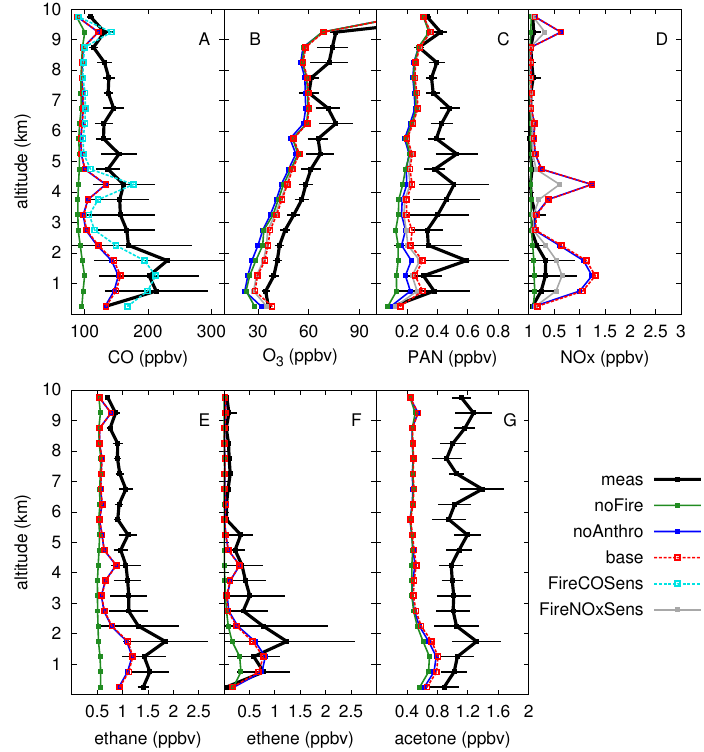
Fig. 3. Vertical profiles (averaged along flight tracks) for CO, ozone, PAN, NO x , ethane, ethene, and acetone for the ARCTAS-B flights over Canada compared to WRF-Chem results – measurements are in black, the model base run is in red, the noFire run is in green, and the noAnthro run is in blue. Two fire emissions sensitivity runs are shown, the FireCOSens run is shown in teal (CO plot only) and the FireNOxSens run is shown in the ozone, PAN, and NO x plots in gray. The points indicate mean values every 500m and the error bars show the standard deviation for the measurements. The flights included for the comparison over the fire source region are the DC8 flights on 29 June and on 1, 4, and 5 July. See text for details.